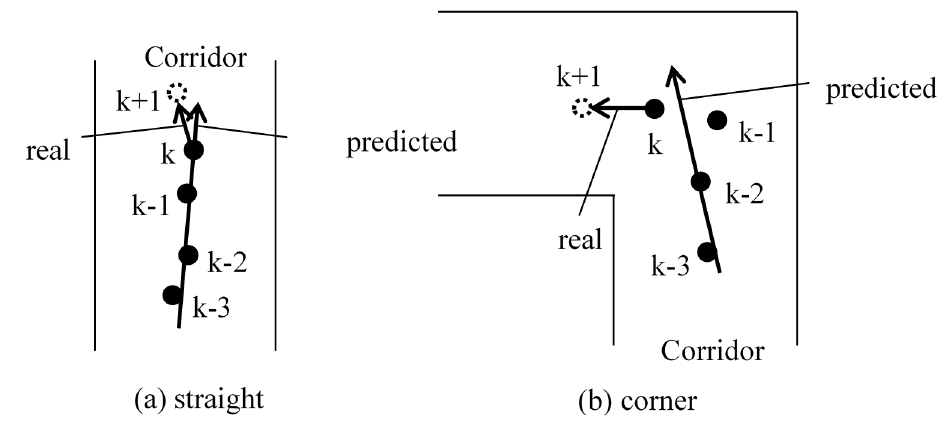
Figure 4. WiFi direction estimate. ( a ) Straight; ( b ) corner.